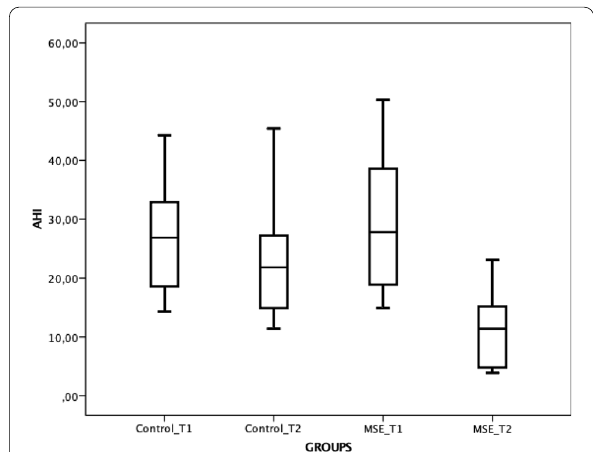
Fig. 4 Boxplot comparing the AHI among the groups and